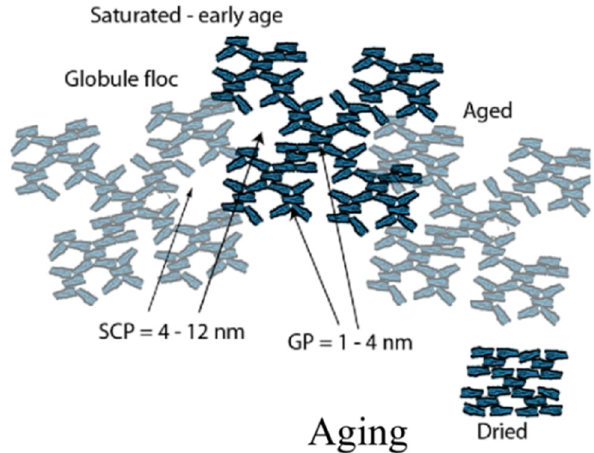
Figure 10: Schematic of particles of C – S – H, referred to as globules or bricks, reprinted with permission from ref. [ 112 ] ; Copyright 2018, Japan Concrete Institute. They are about 4 nm across and have a layered structure with interlayer space and small pores imperfectly aligned. Their packing arrangement is such that the pores tend to have speci fi c sizes and overall packing e ffi ciency.